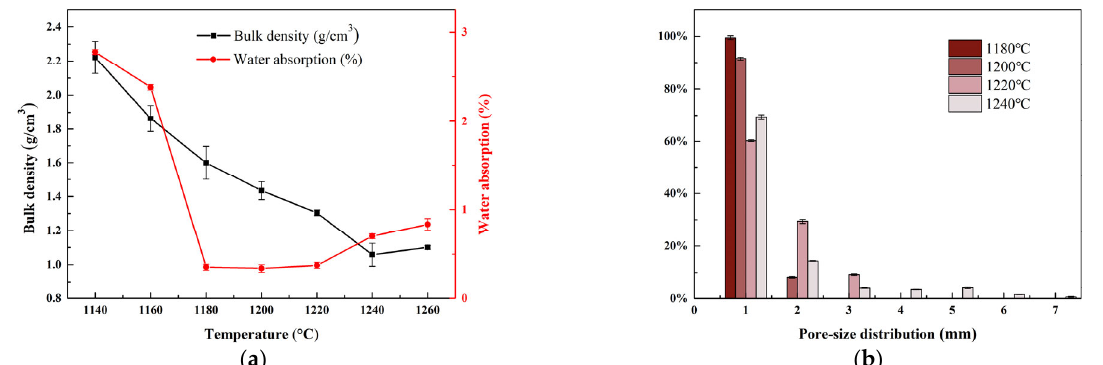
Figure 3. ( a ) Bulk density and water absorption and ( b ) pore size distribution of samples sintered at different temperatures for 20 min.